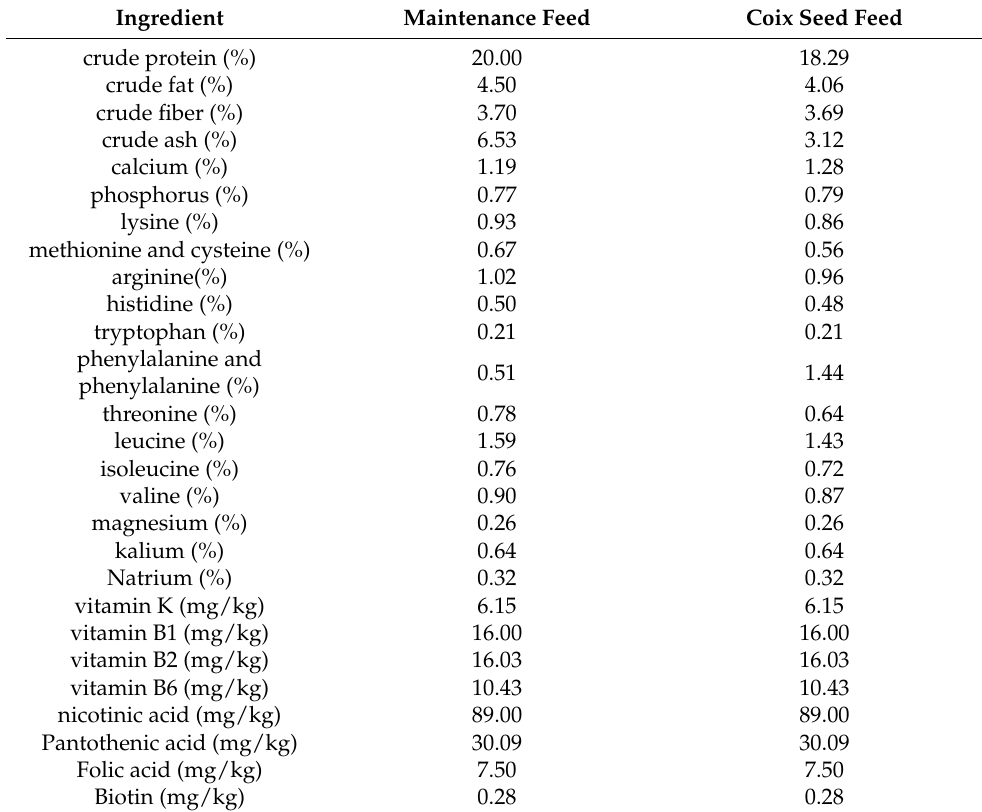
Table 1. The detailed nutritional ingredients of the maintenance and Coix seed feed.